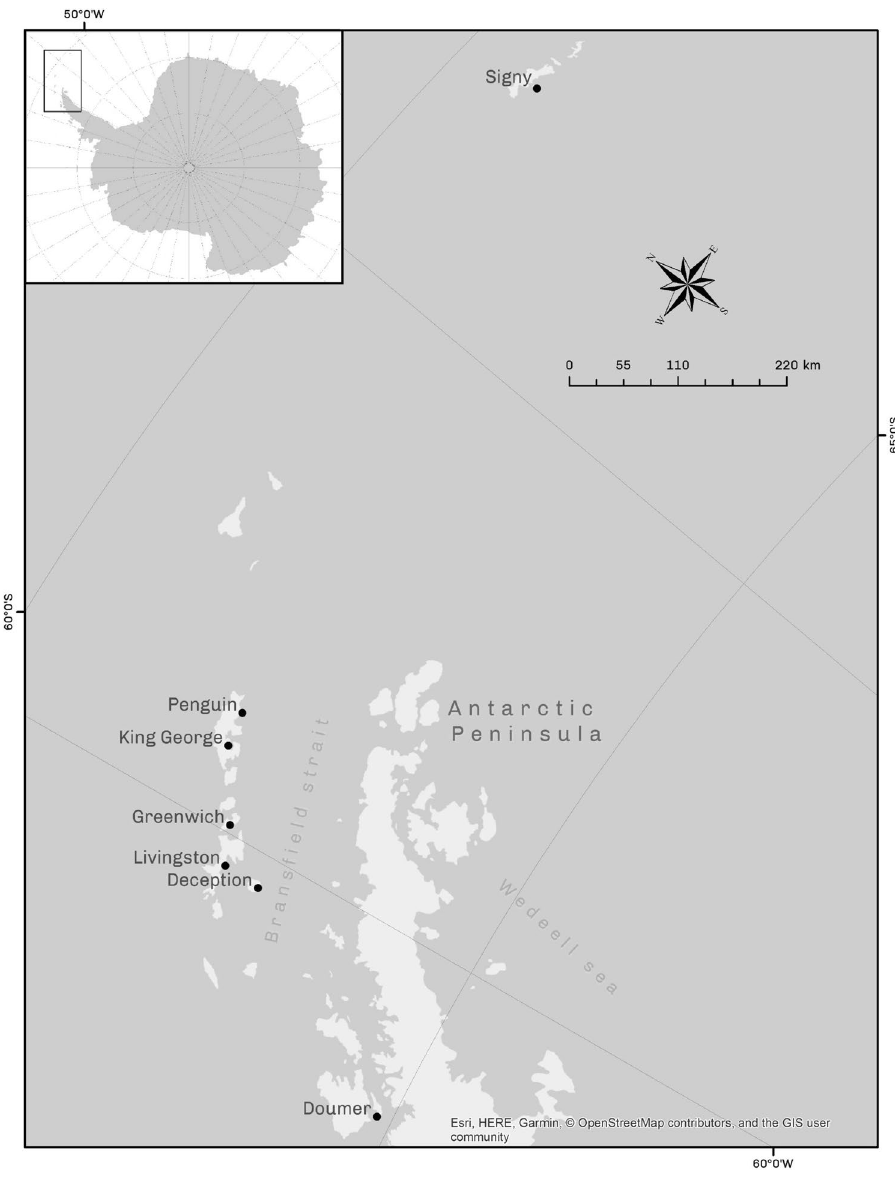
Figure 1. Map of West Antarctic Peninsula depicting sampling locations of K. subquadrata : Signy(1); Penguin(2), King George(3), Greenwich(4), Deception(5), Livingston(6), and (7) Doumer Islands.